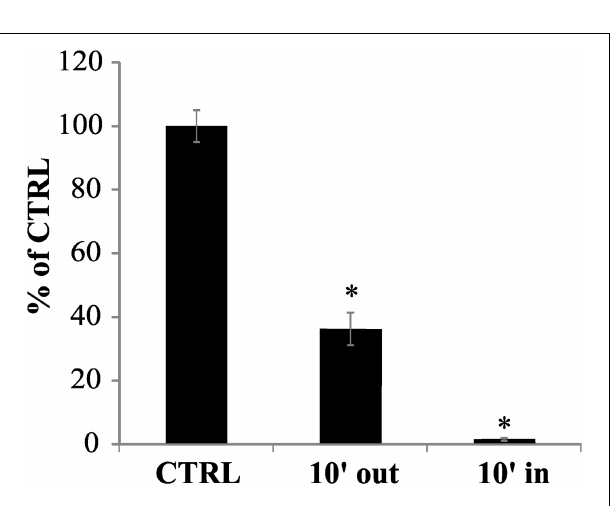
FIGURE 3 | Electron paramagnetic resonance signal of cPTIO incubated in water, PBS, exhausted medium or with dead cells. cPTIO(NNO) was incubated in water, PBS, exhausted medium (EM) or with boiled dead cells (DC). EPR spectra of the samples were detected after 180 min of incubation. Intensities of EPR signals are given as percentage of the total signal at t 0 .